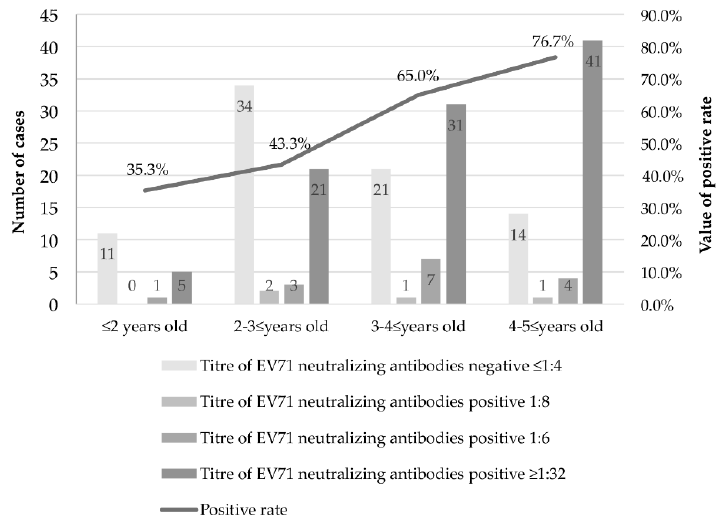
Figure 2. Antibody titre and positive rates of EV71 neutralizing antibodies in different age groups of children. Negative results were determined by titres of antibodies (≤1:4), and positive results were determined by titres of antibodies (1:8, 1:16, and ≥1:32). All neutralizing antibody titre values that exceed 1:32 were recorded as ≥1:32. Positive rates were generated from all positive results.